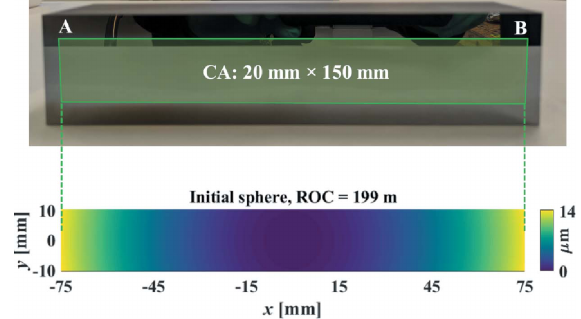
Figure 9 Target elliptical-cylindrical mirror with the object distance p = 14254.7 mm, image distance q = 2448.8 mm and grazing angle (cid:8) = 1.25 (cid:7) .